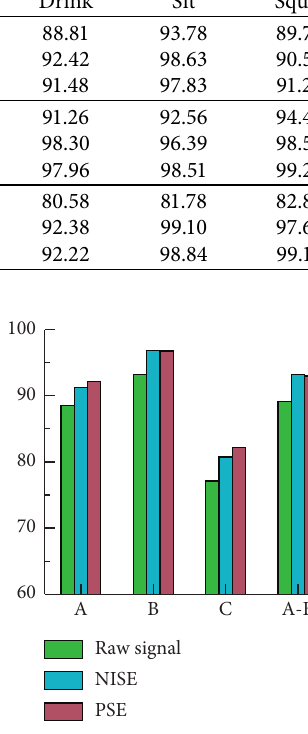
Figure 15: Performance of different approaches on three volun- teers and their fusion data using RF classifier in an empty environment.